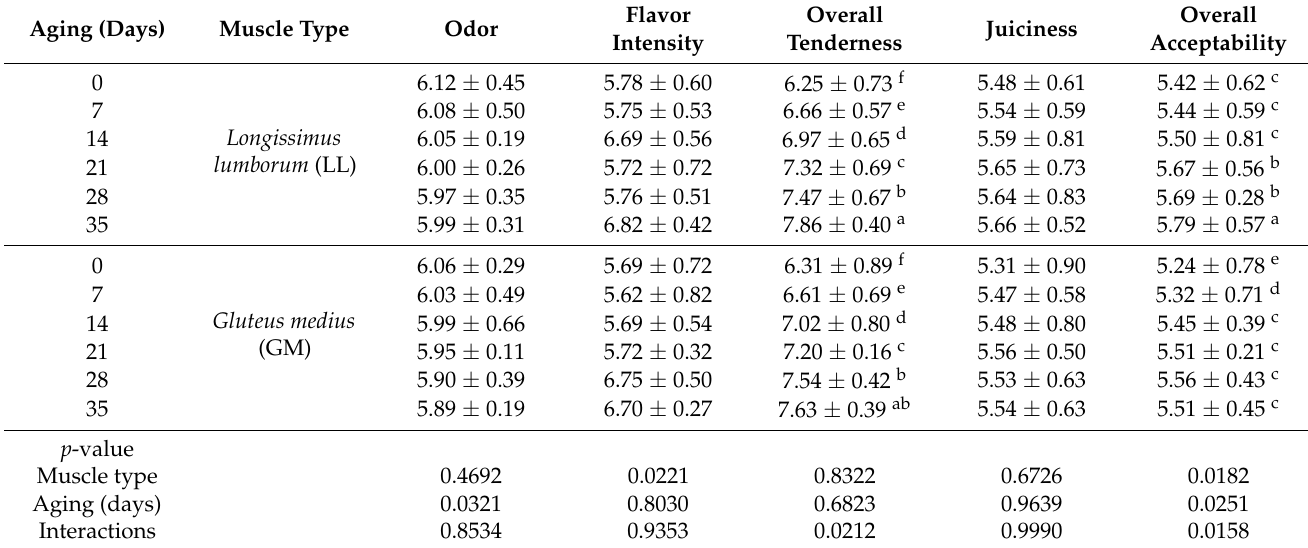
Table 3. Effect of aging time and muscle type on sensory characteristics of Buffalo